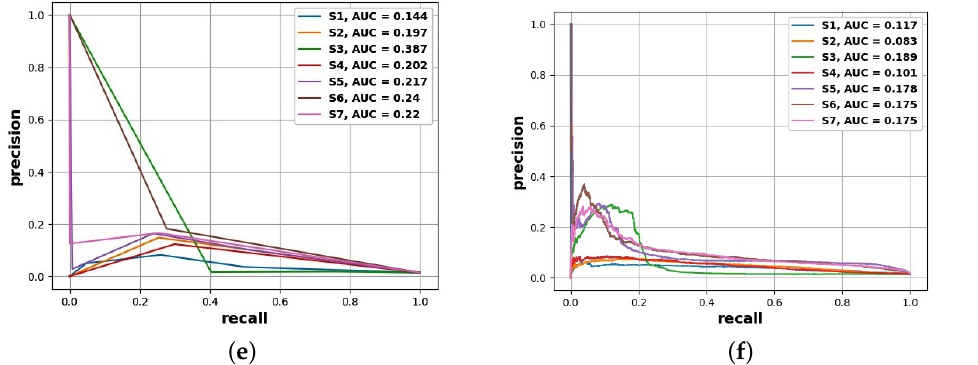
Figure 4. PR curves for particular algorithms and attribute subsets. ( a ) LR classifier; ( b ) SVC classifier;